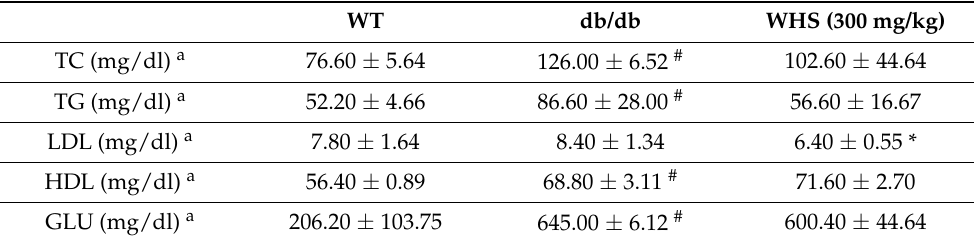
Table 2. The TC, TG, LDL, HDL, and GLU levels of each